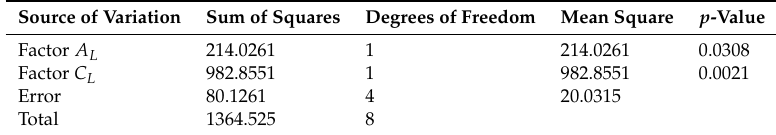
Table 3. Best ANOVA for the L9 orthogonal